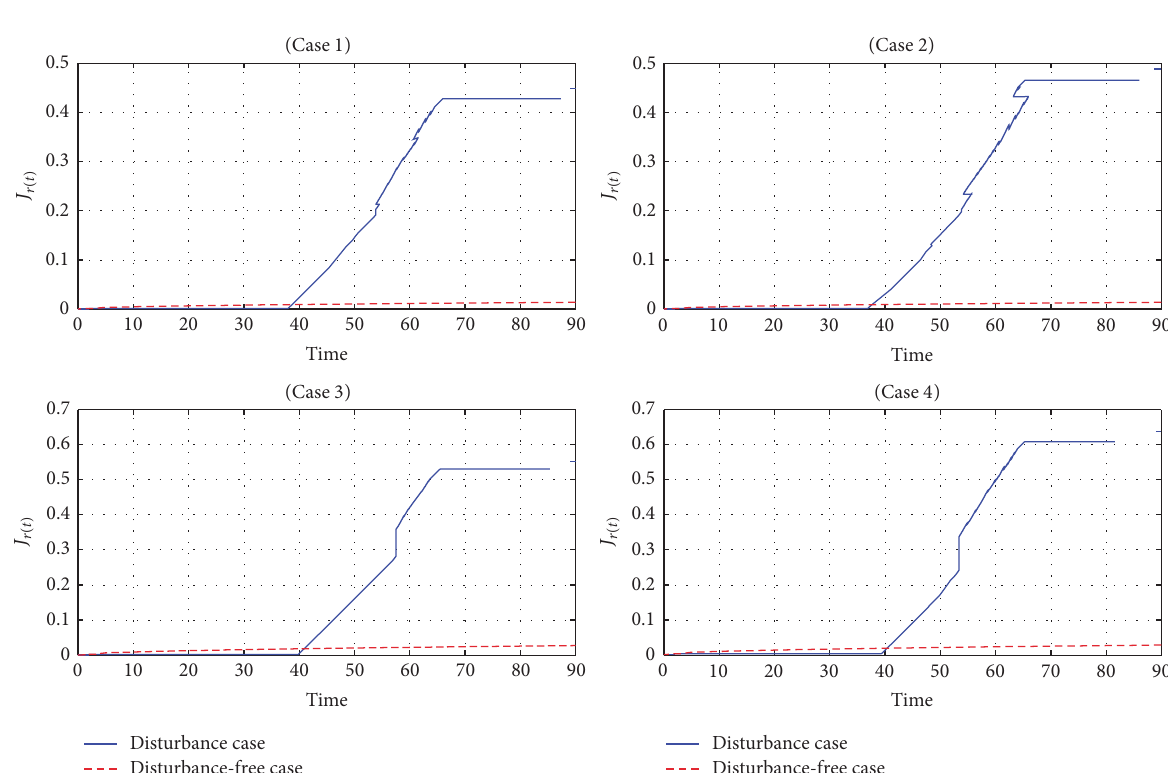
Figure 6: Evolution of 𝐽 𝑟(𝑡) in Example